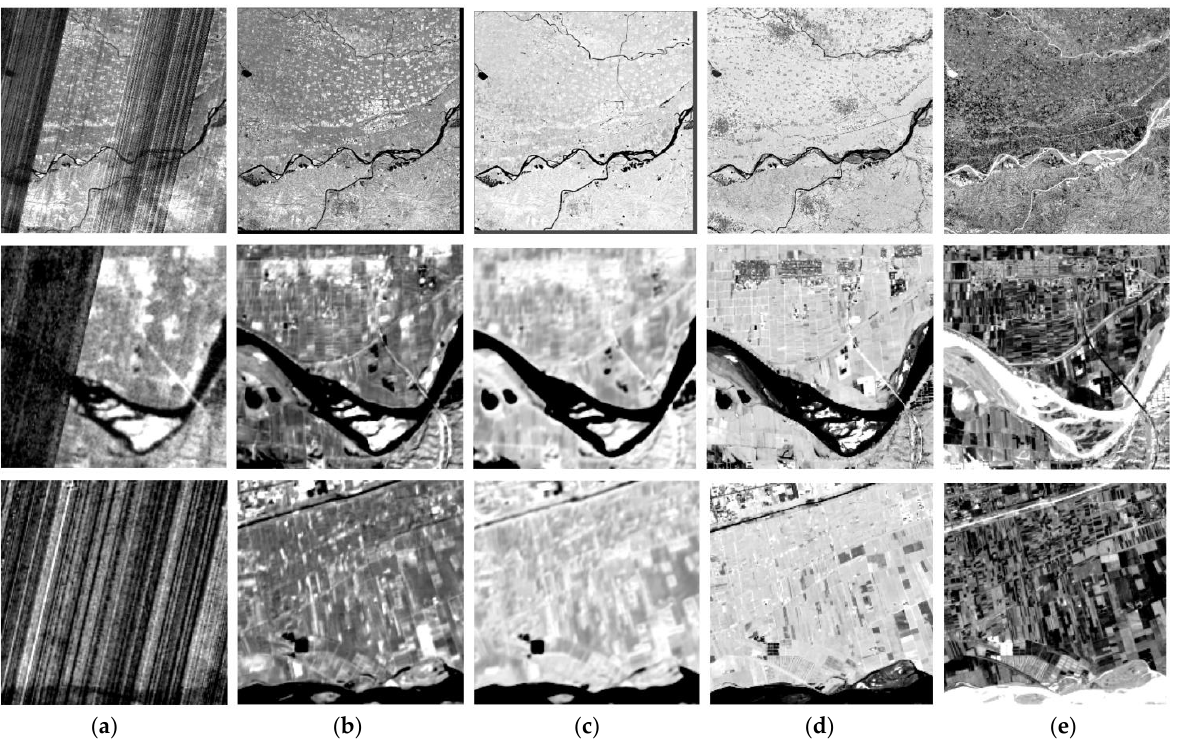
Figure 13. Image of Band 125 of dataset I. ( a ) Original Image, ( b ) SRE-ResNet, ( c ) HSCNN, ( d ) CNMF, ( e ) J-SLoL.